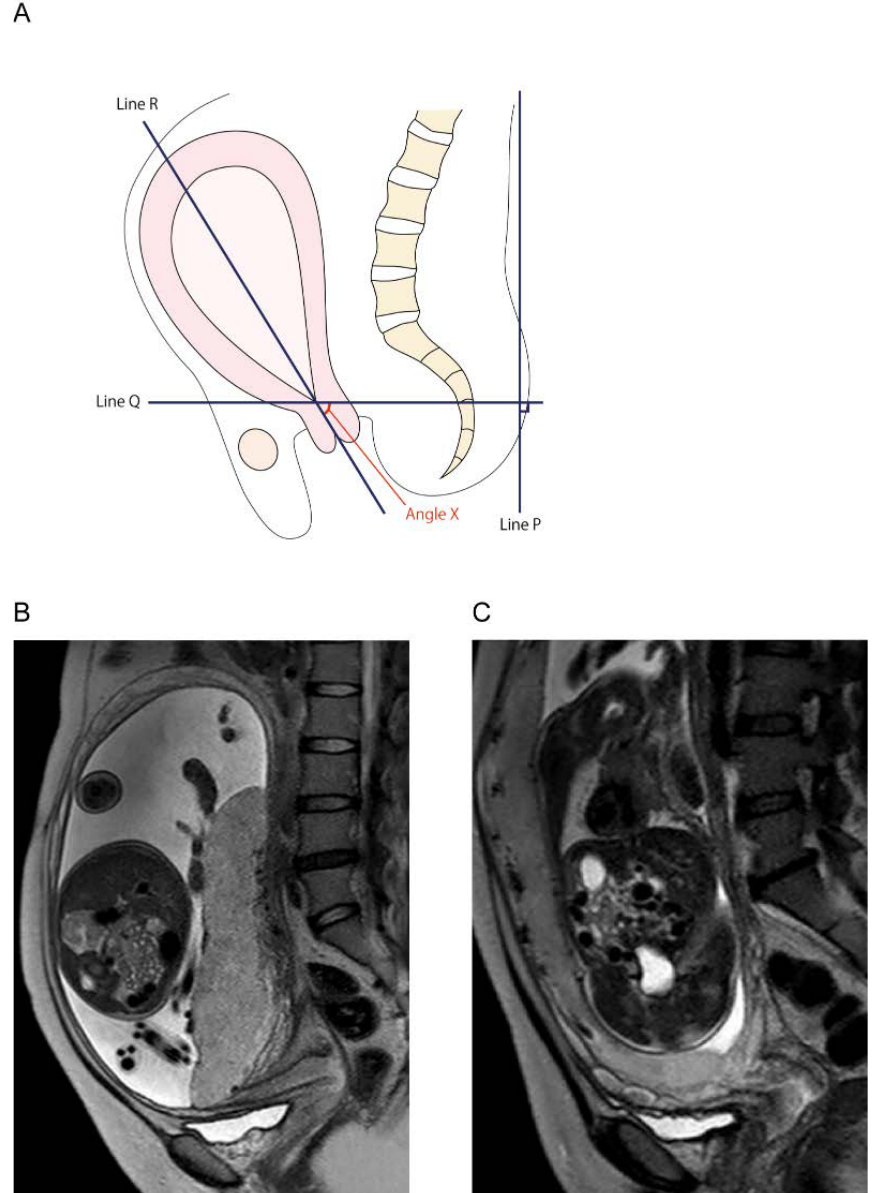
Figure 6. Determination of the cervical canal angle. Modified from BMC Surg. 6 January 2021;21:10. Nagase Y et al. Placenta previa with posterior extrauterine adhesion: clinical features and manage- ment practice/Supplemental Figure S1, Determination of the horizontal cervix sign [56]. ( A ) The method for measuring the angle of the cervical canal on magnetic resonance images. Line P is a straight line through a broad part of the patient’s back. Line Q is a line perpendicular to line P. Line R is a line passing through the internal os to the external os, and Angle X is the angle formed by lines Q and R (defined as the cervical canal angle). ( B ) Typical magnetic resonance imaging of a woman with PP complicated with endometriosis. ( C ) A typical magnetic resonance imaging of a PP patient without endometriosis. Abbreviation: PP, placenta previa.